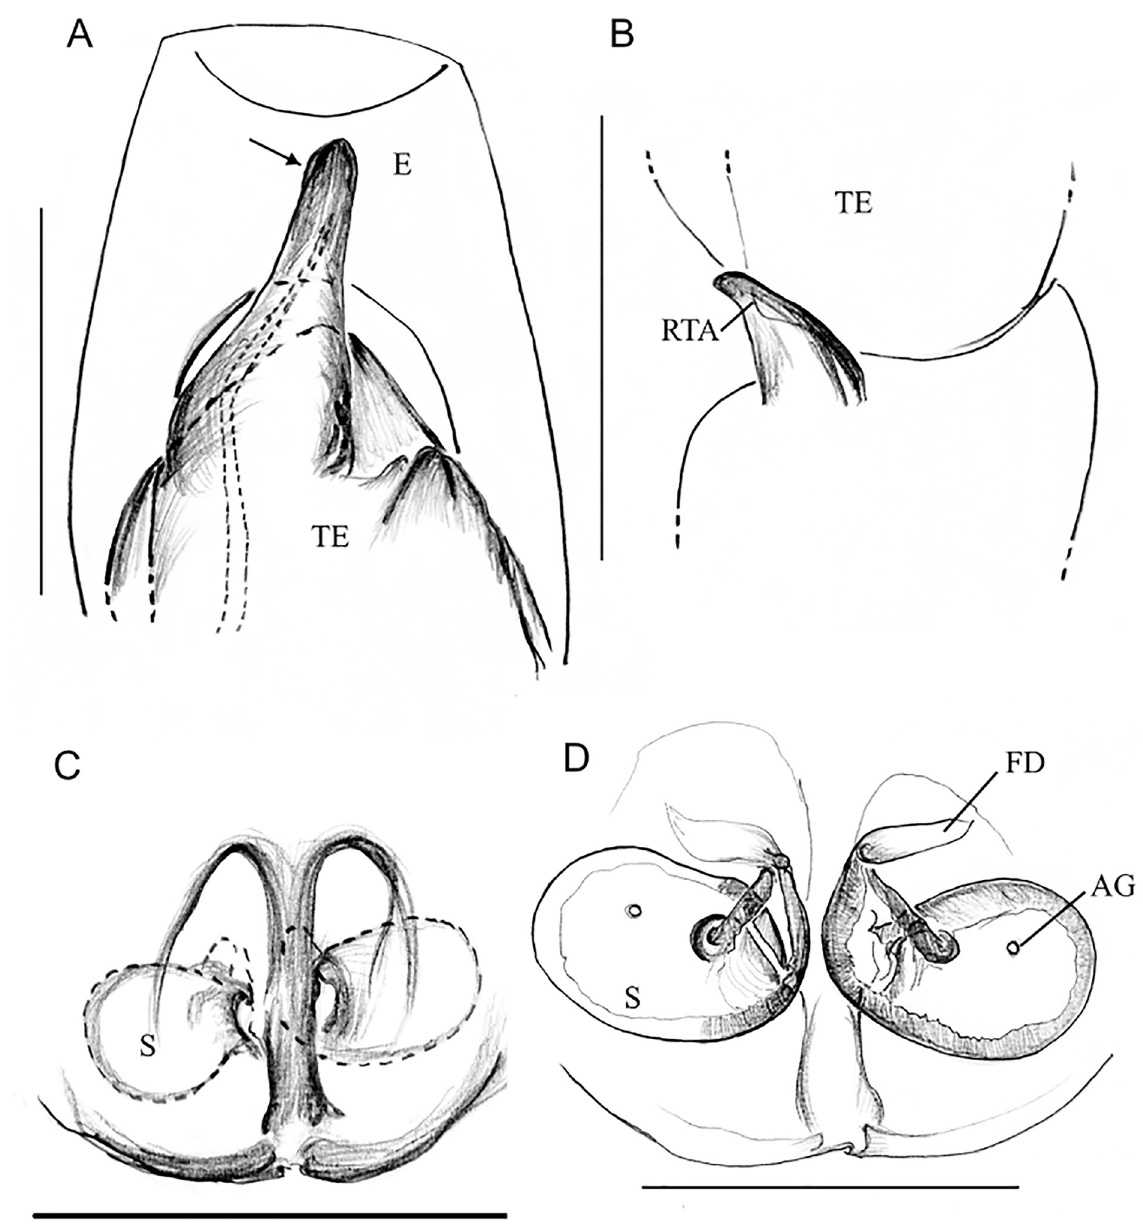
Fig 12. Carrhotus silanthi Caleb, 2020. A–B . Palp. A . Ventral view. B . Retrolateral view. C–D . Epigynum. C . Ventral view. D . Dorsal view. Abbreviations: AG = accessory gland; E = embolus; FD = fertilization duct; RTA = retrolateral tibial apophysis; S = spermatheca; TE = tegulum. Scale bars: A–B = 0.2 mm; C–D = 0.1